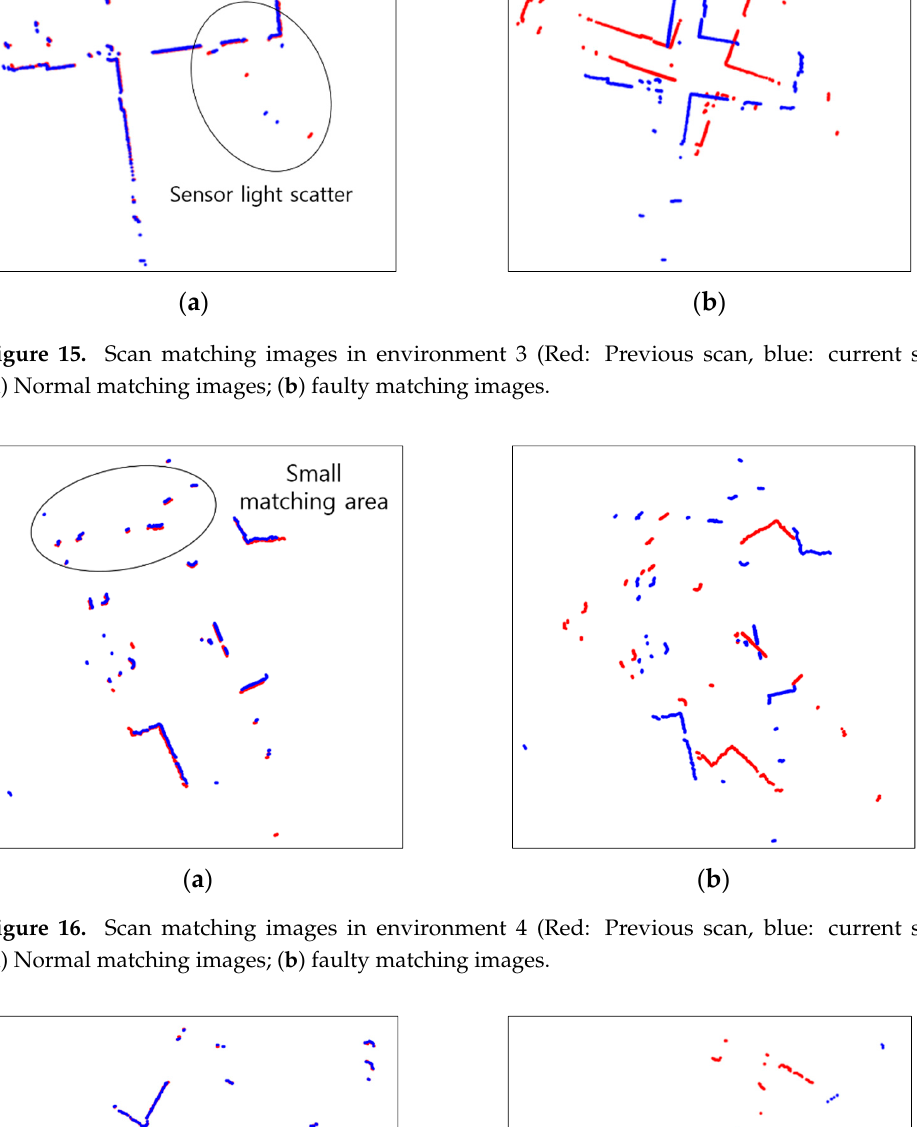
Figure 14. Scan matching images in environment 2 (Red: Previous scan, blue: current scan). ( a ) Nor- mal matching images; ( b ) faulty matching images.